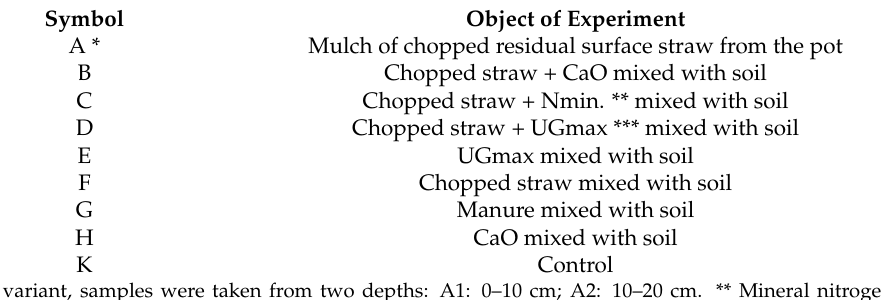
Table 1. Resources shaping soil fertility and methods of their application. Symbol Object of Experiment A * Mulch of chopped residual surface straw from the pot B Chopped straw + CaO mixed with soil C Chopped straw + Nmin. ** mixed with soil D Chopped straw + UGmax *** mixed with soil E UGmax mixed with soil F Chopped straw mixed with soil G Manure mixed with soil H CaO mixed with soil K